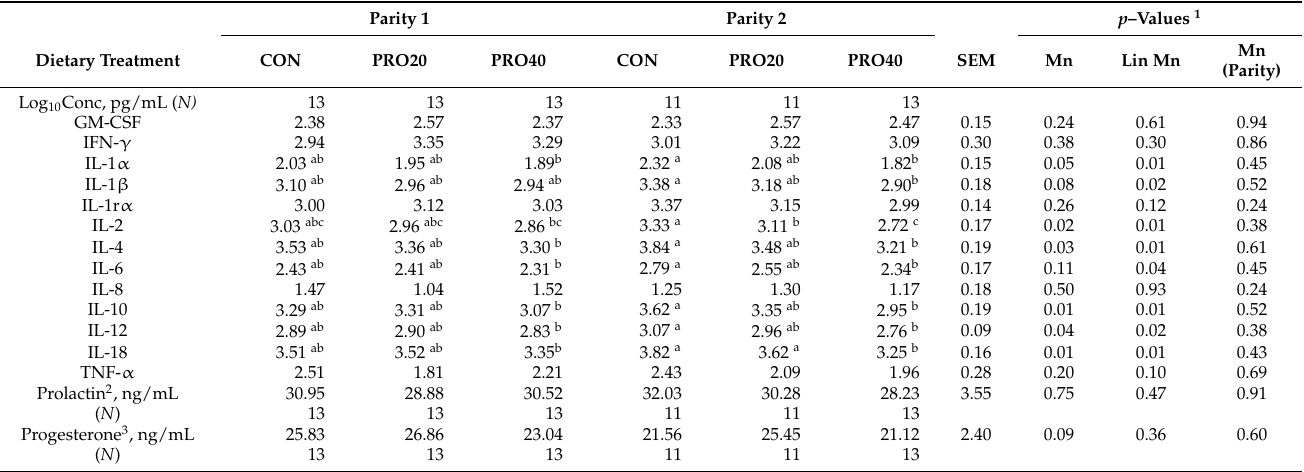
Table 3. The effect of supplemental dietary Mn (0, 20, 40 ppm) on the log concentration of plasma immune markers in sows 3 d into lactation over two parities. Parity 1 Parity 2 p –Values